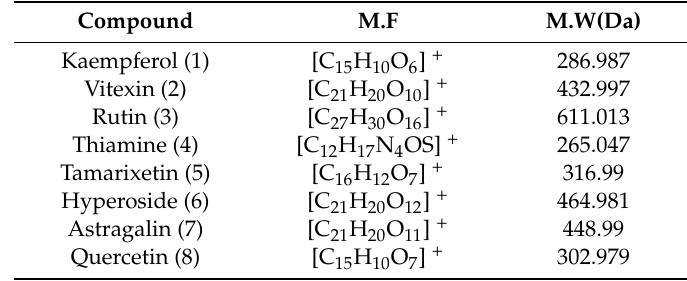
Table 1. Identified compounds from A. pinnata ethanolic extract (APE) using GNPS molecular networking database.